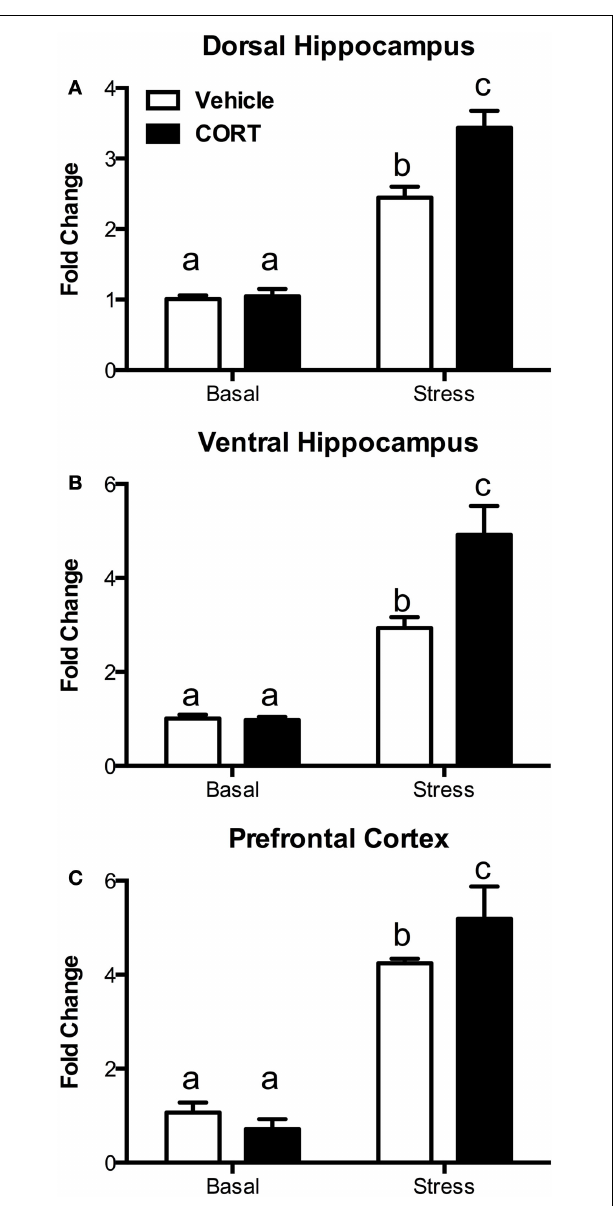
FIGURE 4 |Treatment with CORT in the drinking water results in exaggerated stress-induced c-Fos responses in the brain . Following a 10-min forced-swim stress and a 10-min recovery period, CORT (25 µ g/ml) drinking water-treated mice showed an exaggerated c-Fos mRNA response as measured by RT-PCR in (A) the dorsal hippocampus, (B) the ventral hippocampus, and (C) the prefrontal cortex. CORT treatment did not affect basal non-stressed levels of c-Fos . Columns that share the same letter are not statistically different from each other at the P < 0.05 level.